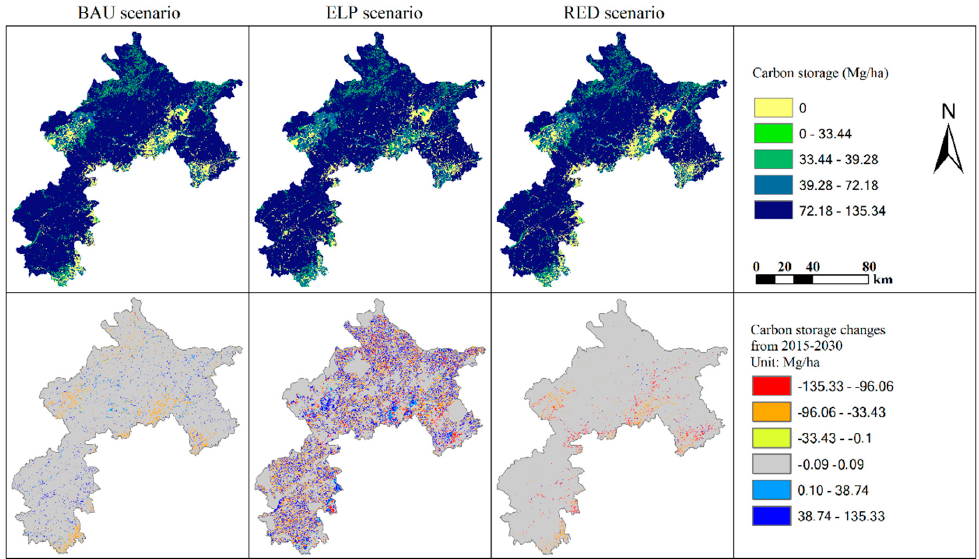
Figure 4. Top, spatial distributions of carbon storage (CS), and bottom, spatial distributions of changes in CS from baseline, in 2030, under the BAU, RED, and ELP scenarios.